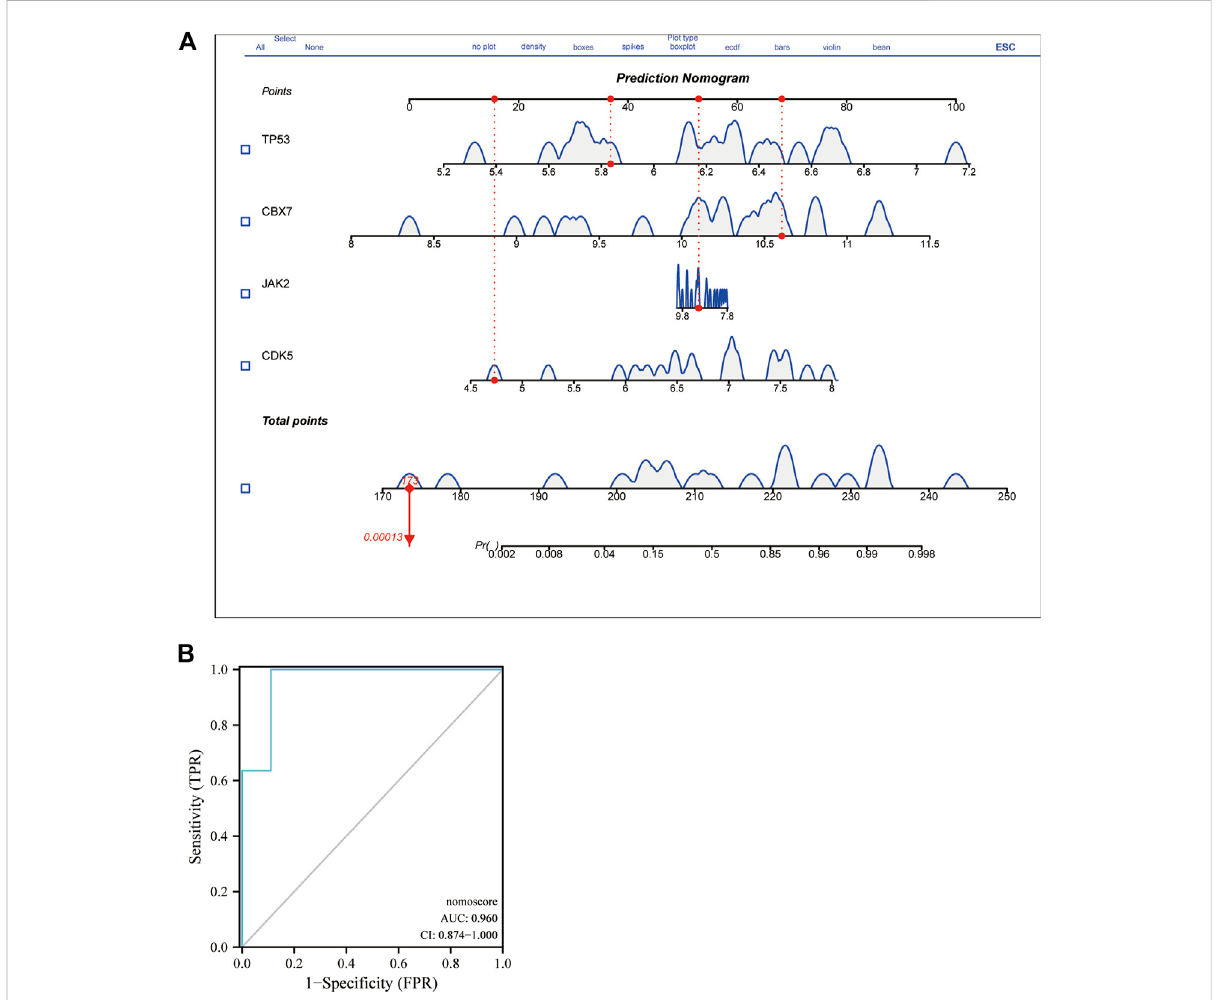
FIGURE 7 NomogramofDECRforADdiagnosisandevaluationofdiagnosticvaluevisualizedfromROCcurves. (A) Anomogramwasdevelopedusingfour externally validated DECRs. Each DECR corresponds to a score on the nomogram. The fi nal score was determined by adding the scores for each DECR. (B) ROC curve of the nomogram revealed DECRs with prominent diagnostic value for AD. AbbreviationsDECR; differentially expressed chromatin regulator; AD, aortic dissection; ROC, receiver operating